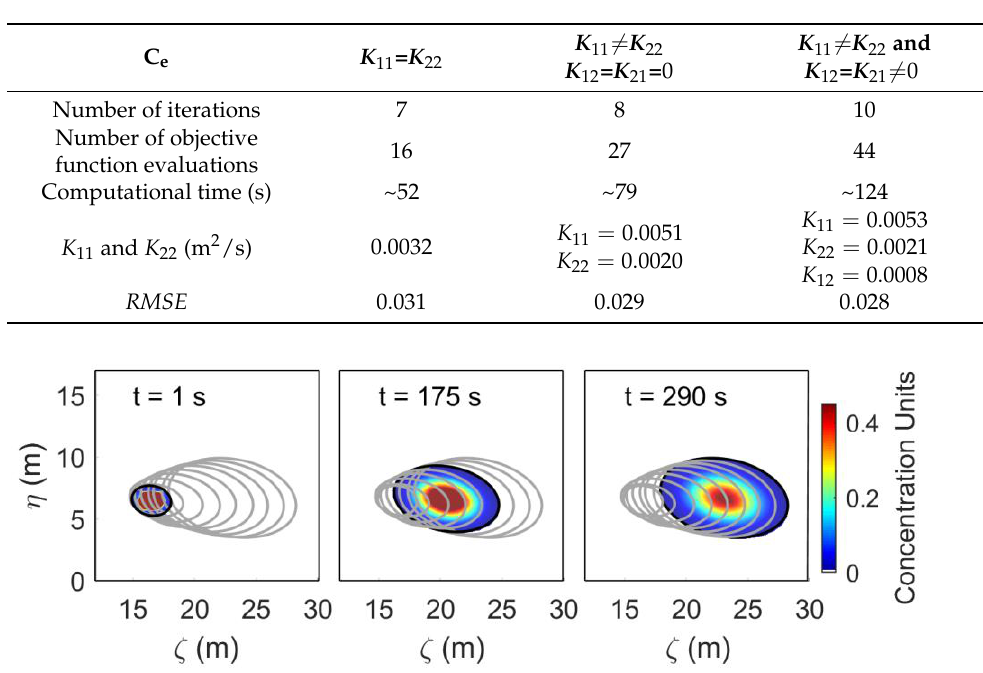
Table 2. Parameters and estimation of the diffusion coefficient.